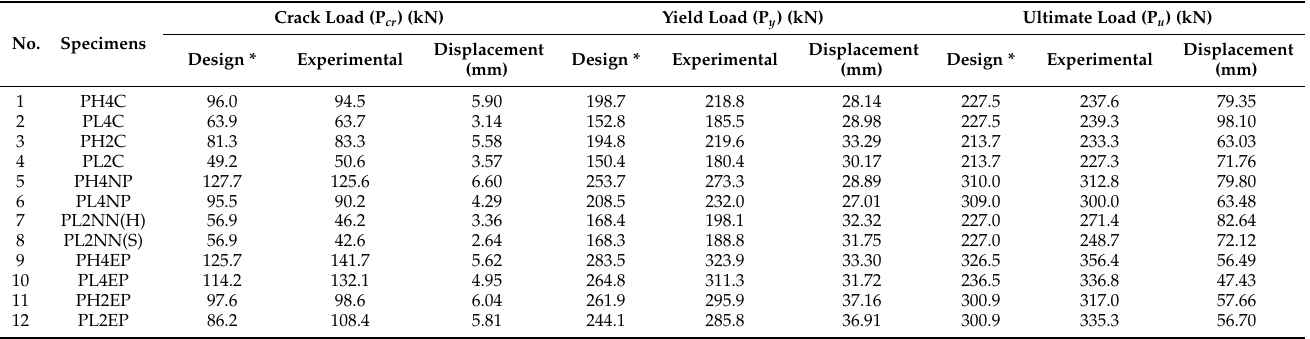
Table 4. Comparison of design and experimental outcomes of crack, yield, and ultimate loads. No.